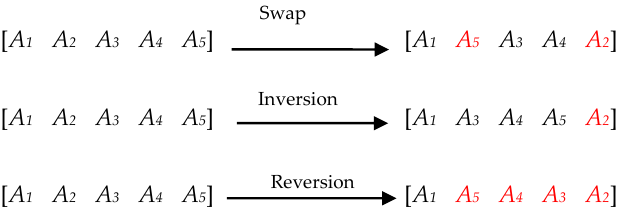
Figure 2. Pseudo code for modified FA.